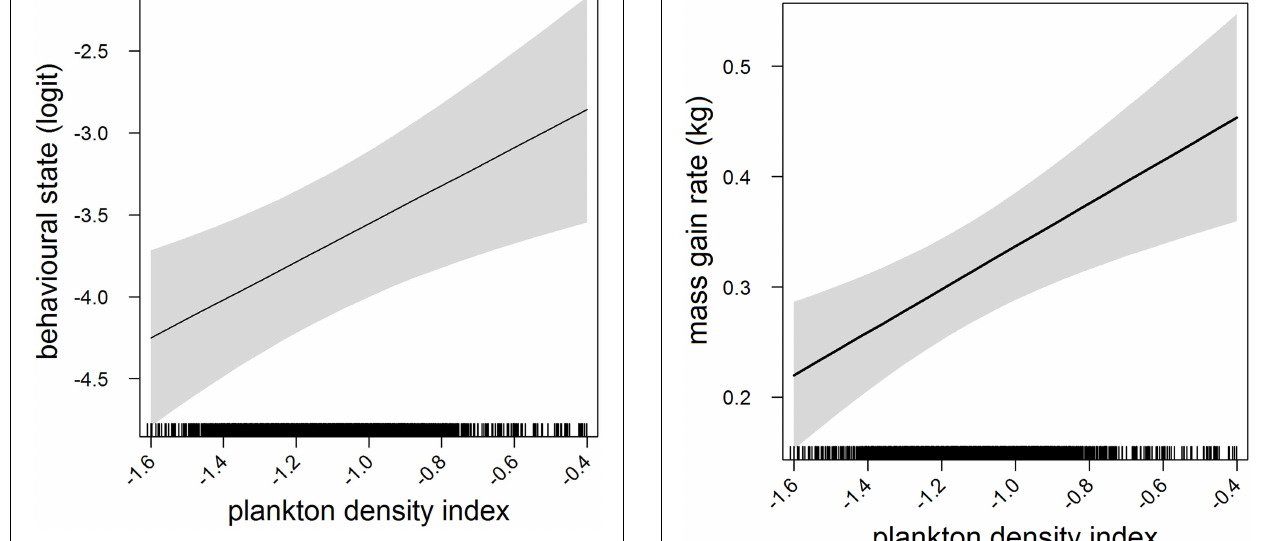
FIGURE 1 | Effects plot of the relationship between plankton densities encountered by seals (i.e., PDI) and their behavioral state from our mixed model analysis. Shaded area indicates the confidence interval. Behavioral state has been logit transformed (higher values indicated an increasing likelihood of seals exhibiting horizontal search activity).